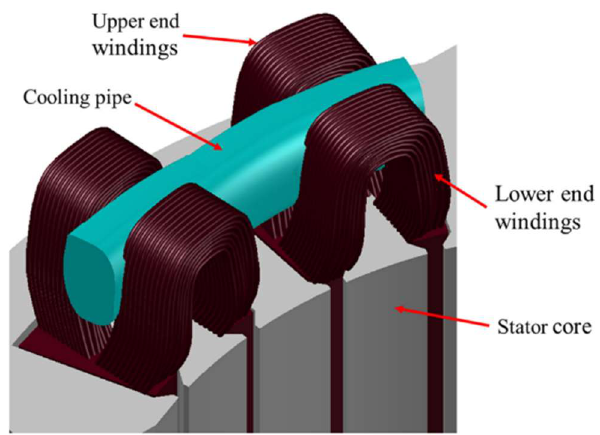
Figure 8. Split end-winding with a cooling pipe [32].